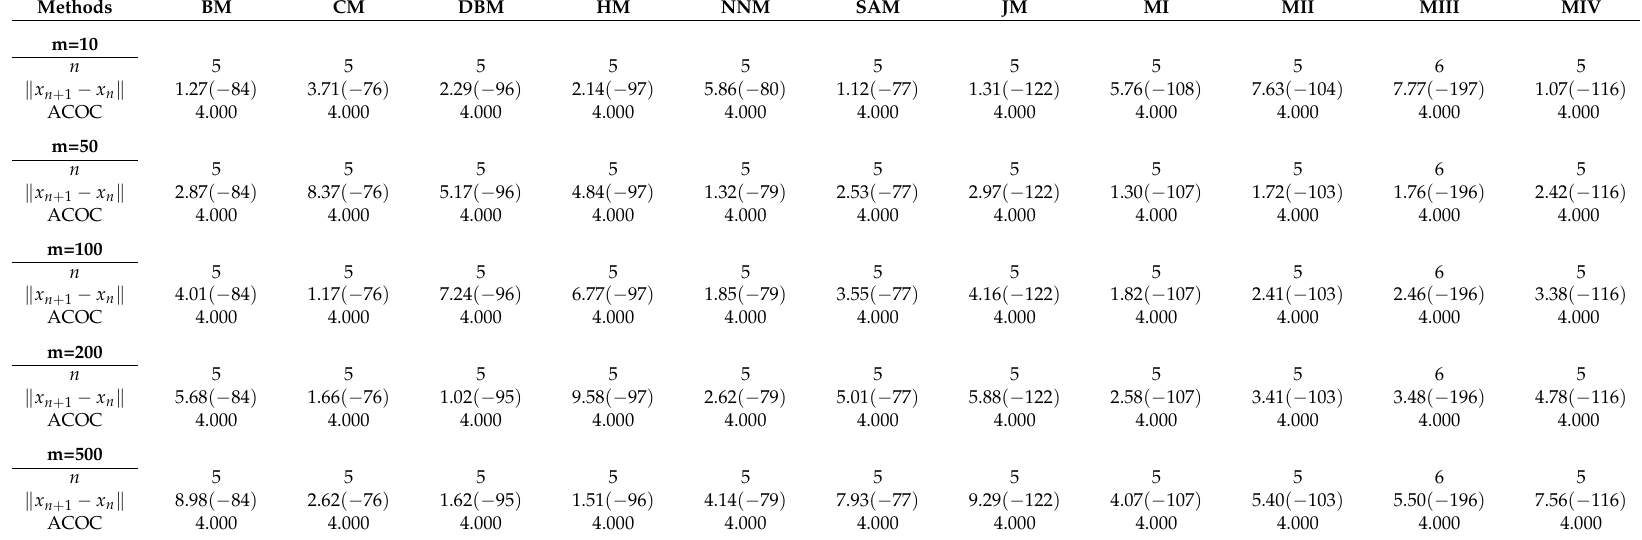
Table 5. Comparison of performance of methods for Problem